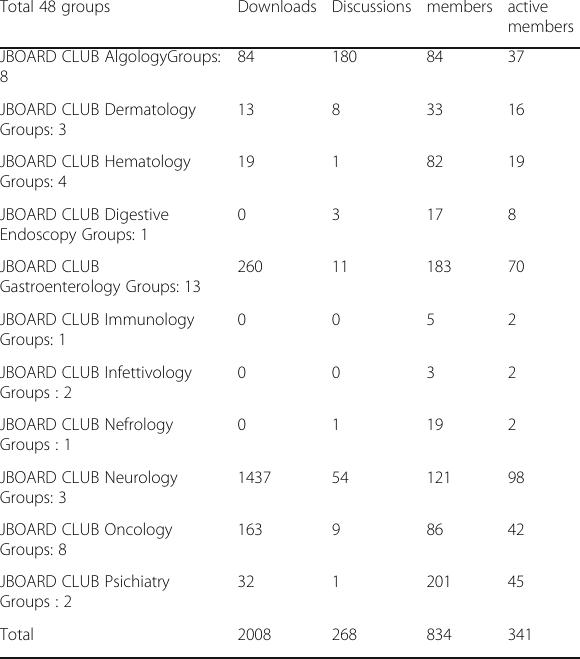
Table 1 (abstract P201). See text for